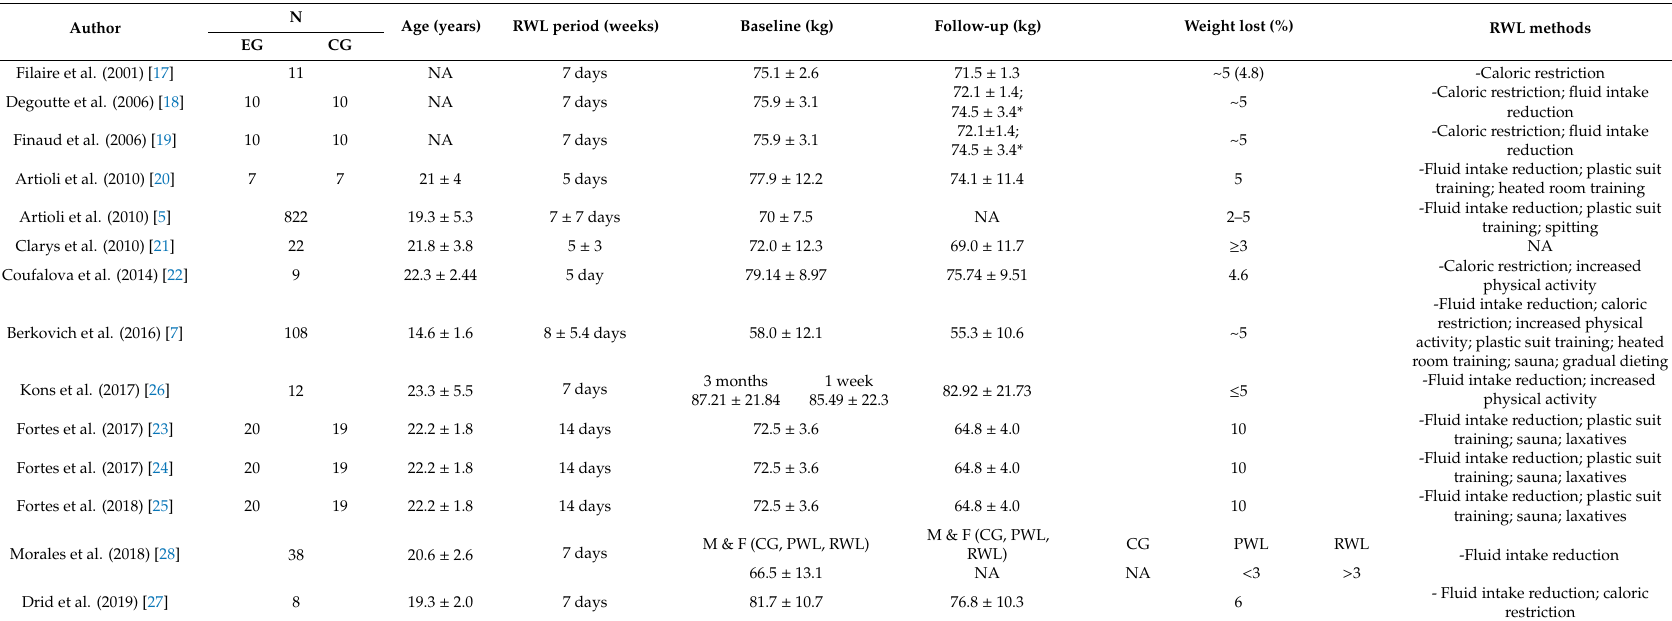
Table 1. Study design and participants’